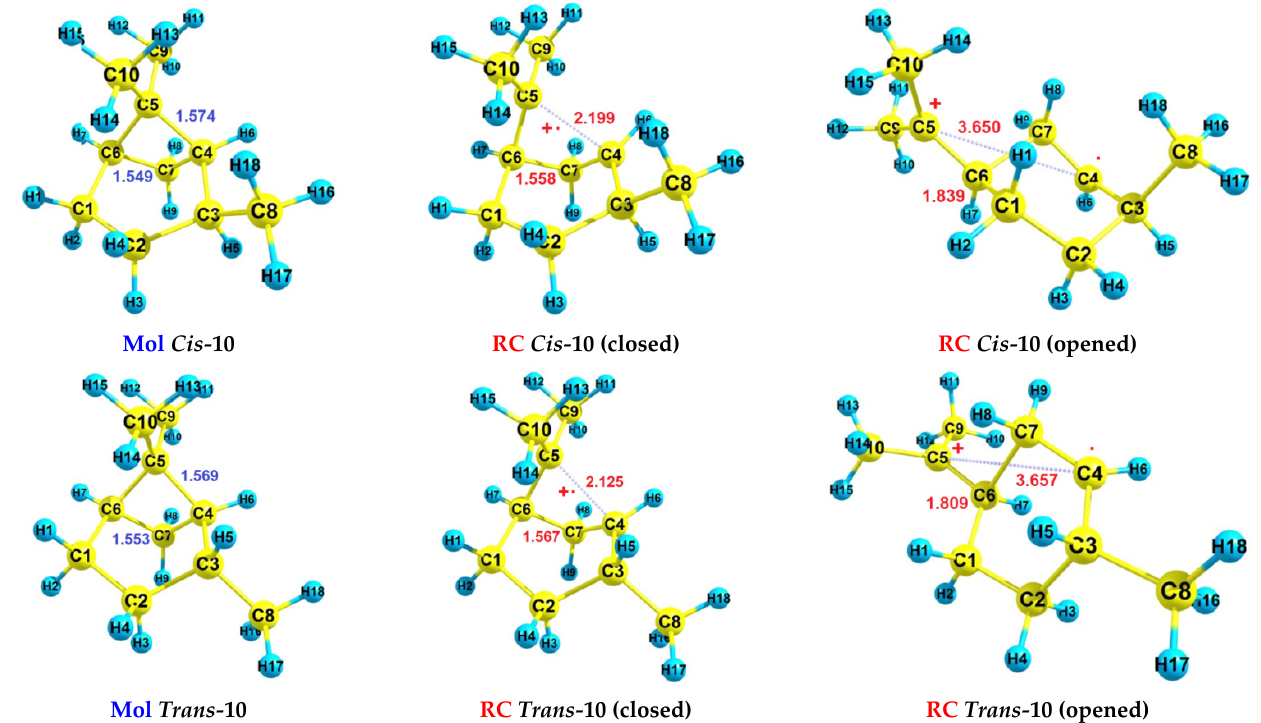
Figure 9. DFT calculated geometries of RH 10 molecule ( Mol ) and its two forms of radical cations ( RC ), bound lengths in Å.